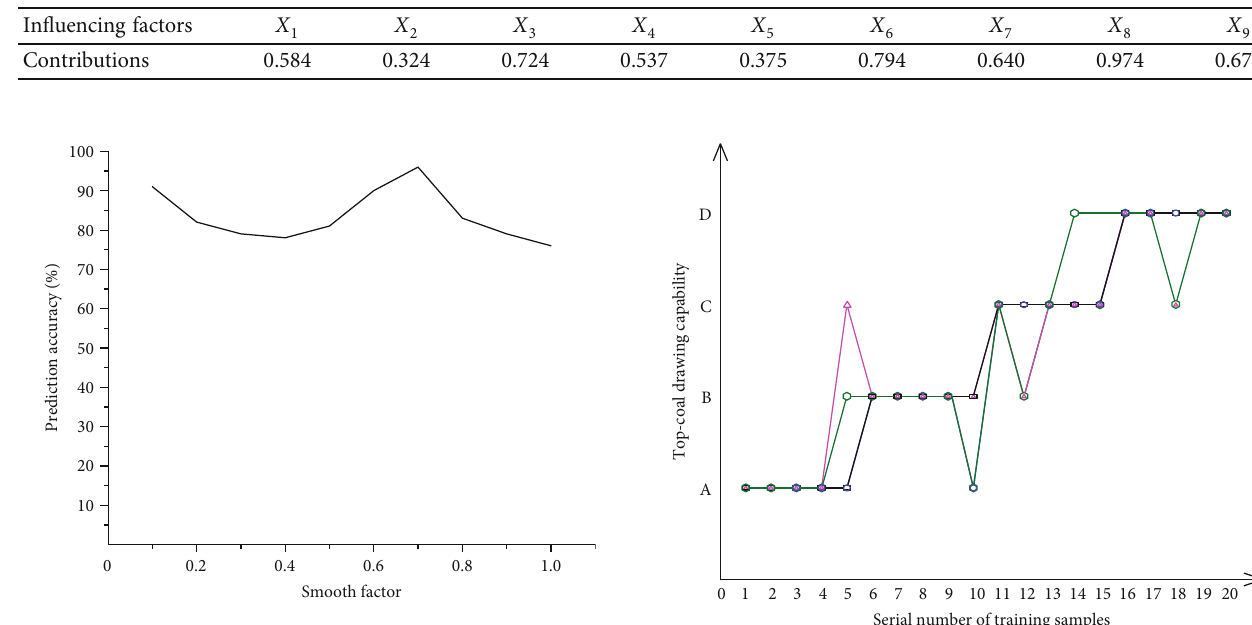
Figure 3: Relationship between the smoothing factor and prediction accuracy.